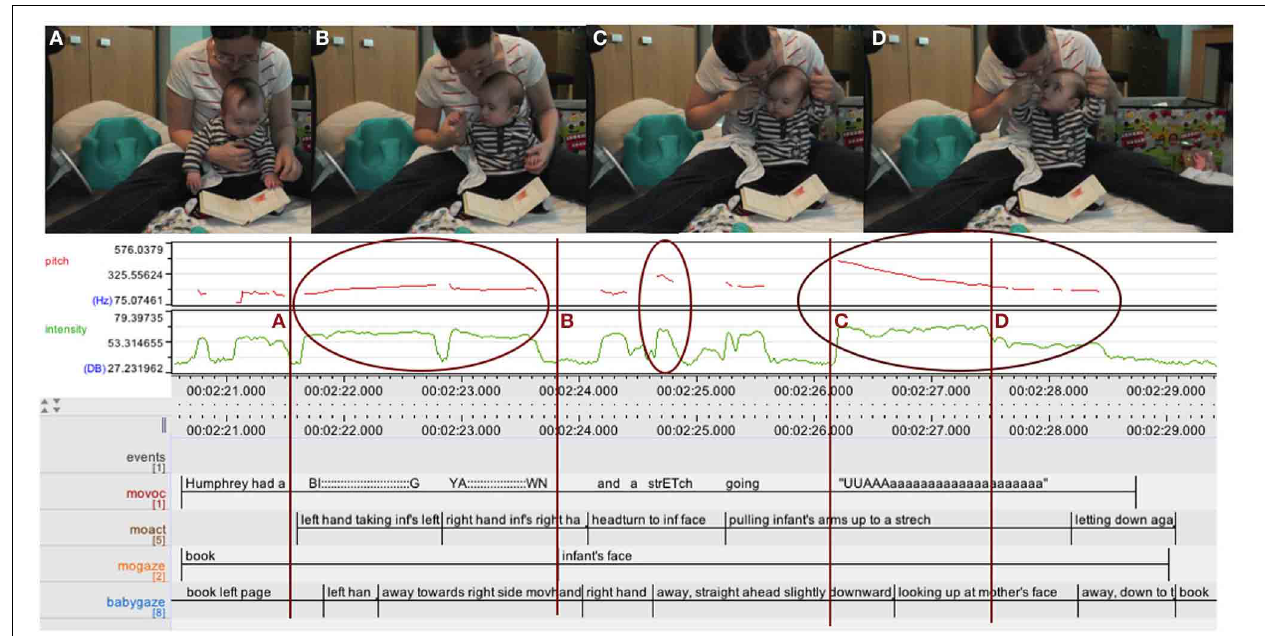
FIGURE 5 | ELAN analysis detail showing pitch (red) and intensity (green) curves. Mother enacting and embodying a “BI::g YA:::wn and a STREtch” vocally and through acting on the 5-month-old infant’s body (highlighted). Upper case letters (A–D) map upper row stills to ELAN time